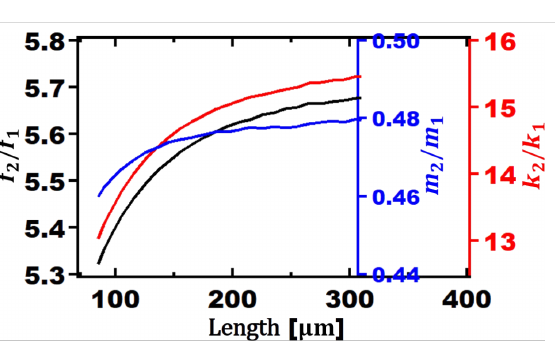
Figure 3: Ratio of second eigenmode to first eigenmode as a function of the length of V-shaped cantilevers for: frequency (black axis), mass (blue axis), and stiffness (red axis). The other geometrical parameters are: = 15 µm, b ref = 86 µm, and t ref = 0.4